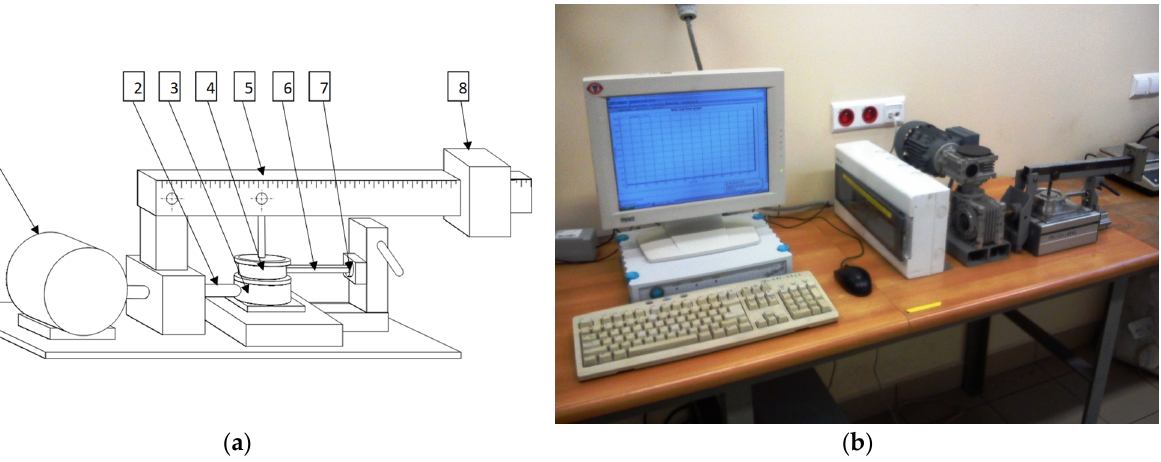
Figure 1. ( a ) Schematic representation of the Jenike-type shear tester: 1—drive engine, 2—drive pin, 3—movable shear cell, 4—immovable shear cell, 5—lever, 6—arm of immovable shear cell, 7—shear stress transducer, 8—normal load; ( b ) Picture of Jenike-type shear tester.